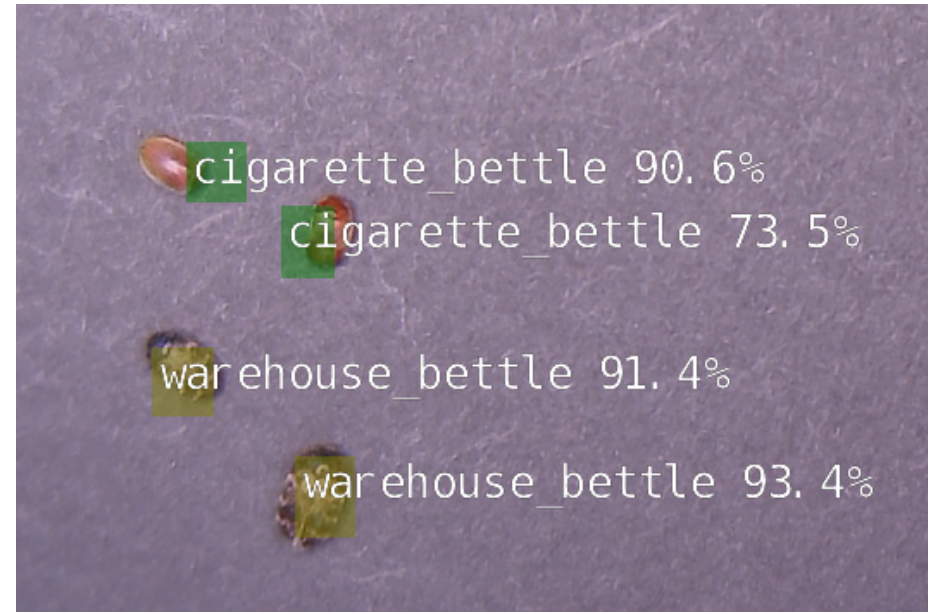
Figure 9. The actual live camera shot detected and identified the beetle side-by-side.